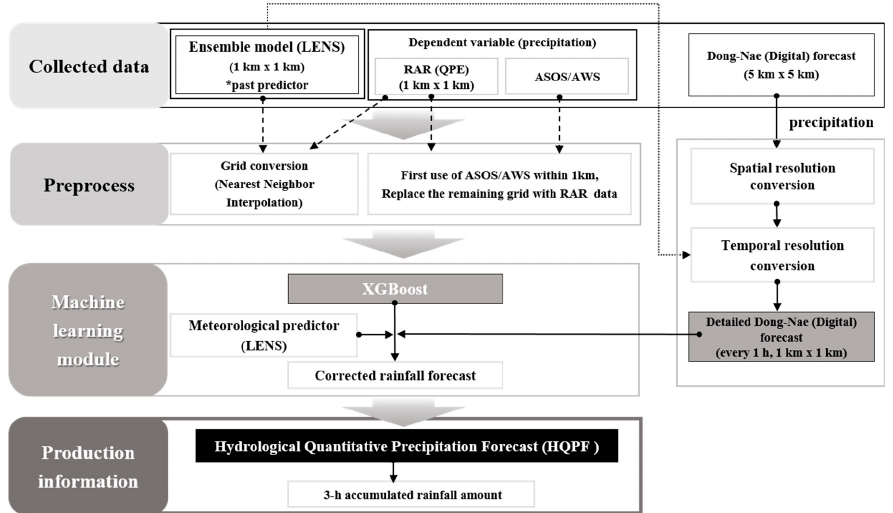
Figure 3. HQPF calculation process. Figure 2. Mimetic diagram for machine learning training.